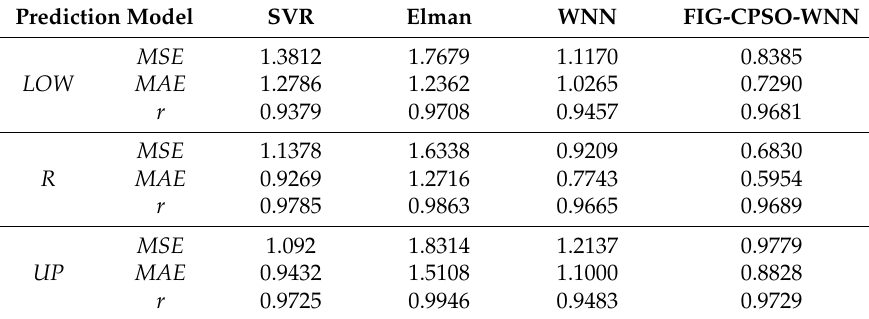
Table 3. Performance evaluation of three models.